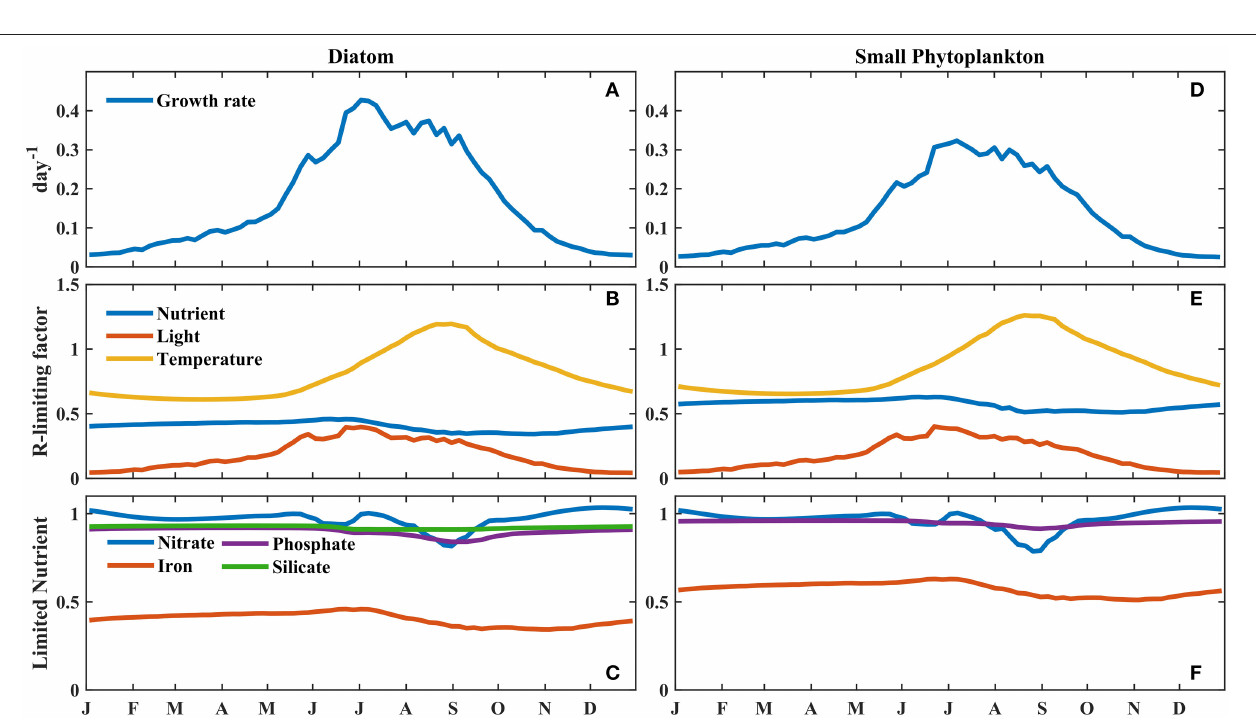
FIGURE 5 | Modeled seasonal cycle of the growth rates of phytoplankton at (A,B) Stn. K2 and (C,D) Stn. Papa. (B,D) Small phytoplankton and, (A,C) diatoms. The black dashed lines represent the MLD.